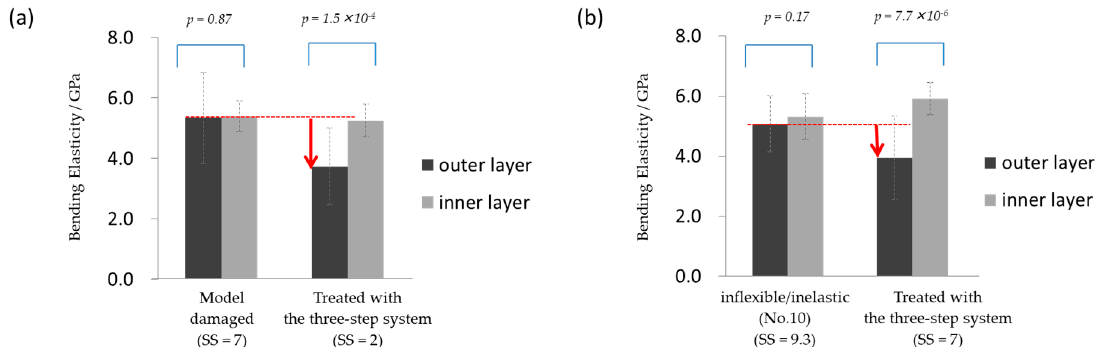
Figure 9. Change in mechanical properties when treated with three-step system using SA. ( a ) Model damaged hair ( b ) inflexible/inelastic chemically untreated hair. Measurements at 20°C and 65% relative humidity (RH), n = 20, SS = sensory score.